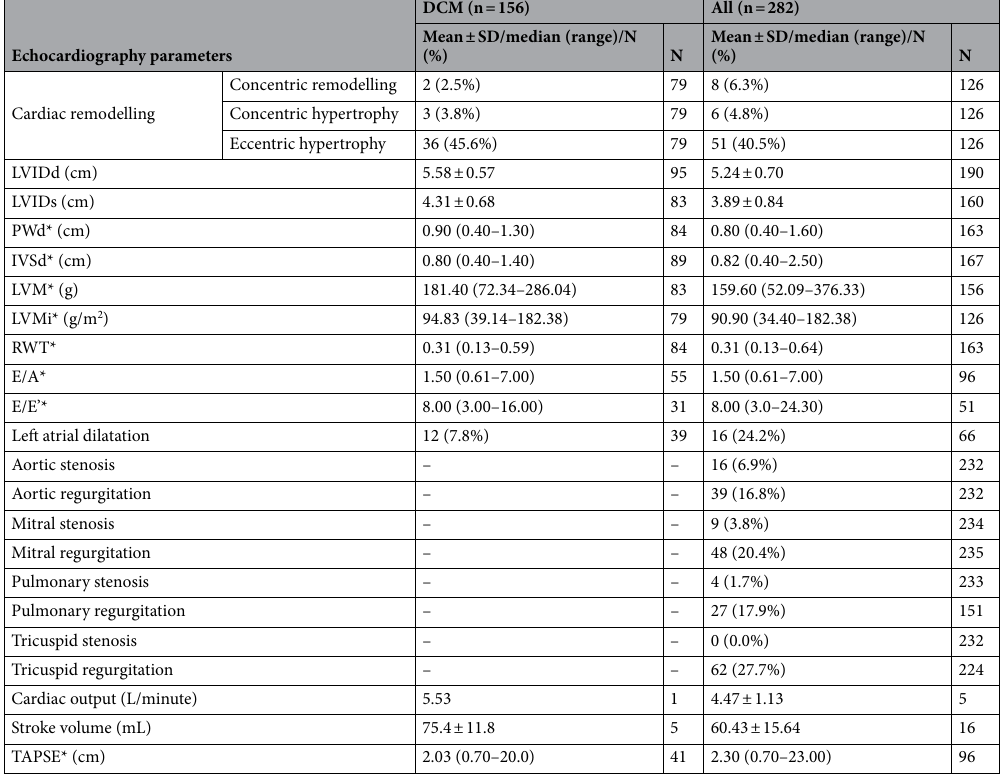
Table 2. Echocardiography measures of cardiac structure and function prior to pregnancy or before 12 weeks’ gestation. Frequencies: N (%). Mean ± standard deviation. *Median (range). Mild, moderate and severe valvular abnormalities were included; trivial and physiological regurgitation/stenosis were excluded. Echocardiography data was not available for all women, therefore the number included in the analysis (N) is recorded for each parameter. SD Standard deviation, LVIDd Left ventricular internal diameter in end-diastole, LVIDs Left ventricular internal diameter in end-systole, PWd Posterior wall thickness in end-diastole, IVSd Interventricular septal wall thickness in end-diastole, LVM Left ventricular mass, LVMi LVM indexed to body surface area, RWT Relative wall thickness, E/A Early to late diastolic filling ratio, E/E’ Early diastolic filling to early diastolic mitral annular velocity ratio, TAPSE Tricuspid annular plane systolic